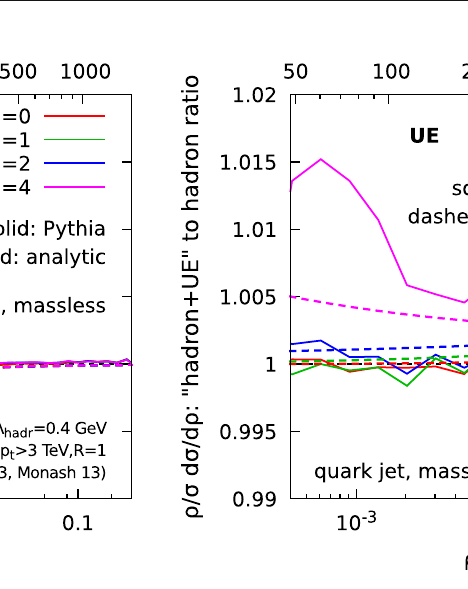
Left: hadronisation corrections (i.e. ratio of hadron level to parton level) for Λ hadr = 0 . 4 GeV; right: Underlying Event corrections (i.e. ratio of distributions with and without UE) for Λ UE = 1 GeV